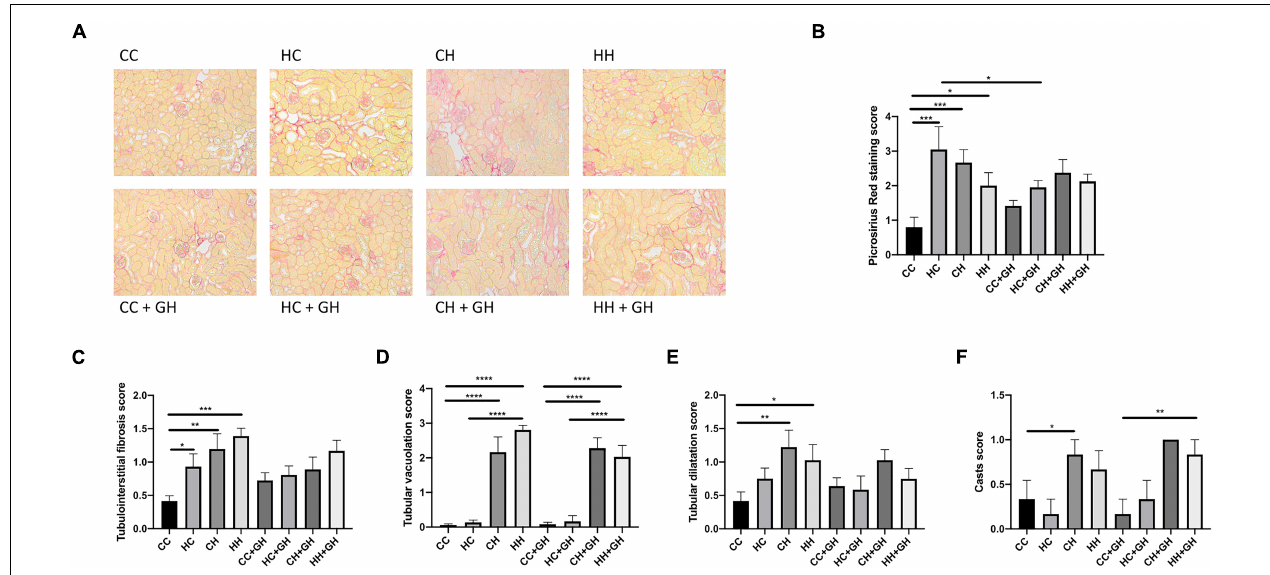
FIGURE 5 | Renal structural changes. (A) Representative images of picrosirius red staining at 200 × magnification, (B) quantitation of picrosirius red staining, (C) tubulointerstitial fibrosis, (D) tubular vacuolation, (E) tubular dilatation, (F) casts. Results expressed as mean ± SEM, n = 6 * p < 0.05, ** p < 0.01, *** p < 0.001, **** p < 0.0001. CC, control offspring; HC, lean offspring of obese mothers; CH, obese offspring of lean mothers; HH, obese offspring of obese mothers; CC + GH, control offspring exposed to gestational hydralazine; HC + GH, lean offspring of obese mothers with gestational hydralazine; CH + GH, obese offspring of lean mothers with gestational hydralazine; HH + GH, obese offspring of obese mothers with gestational